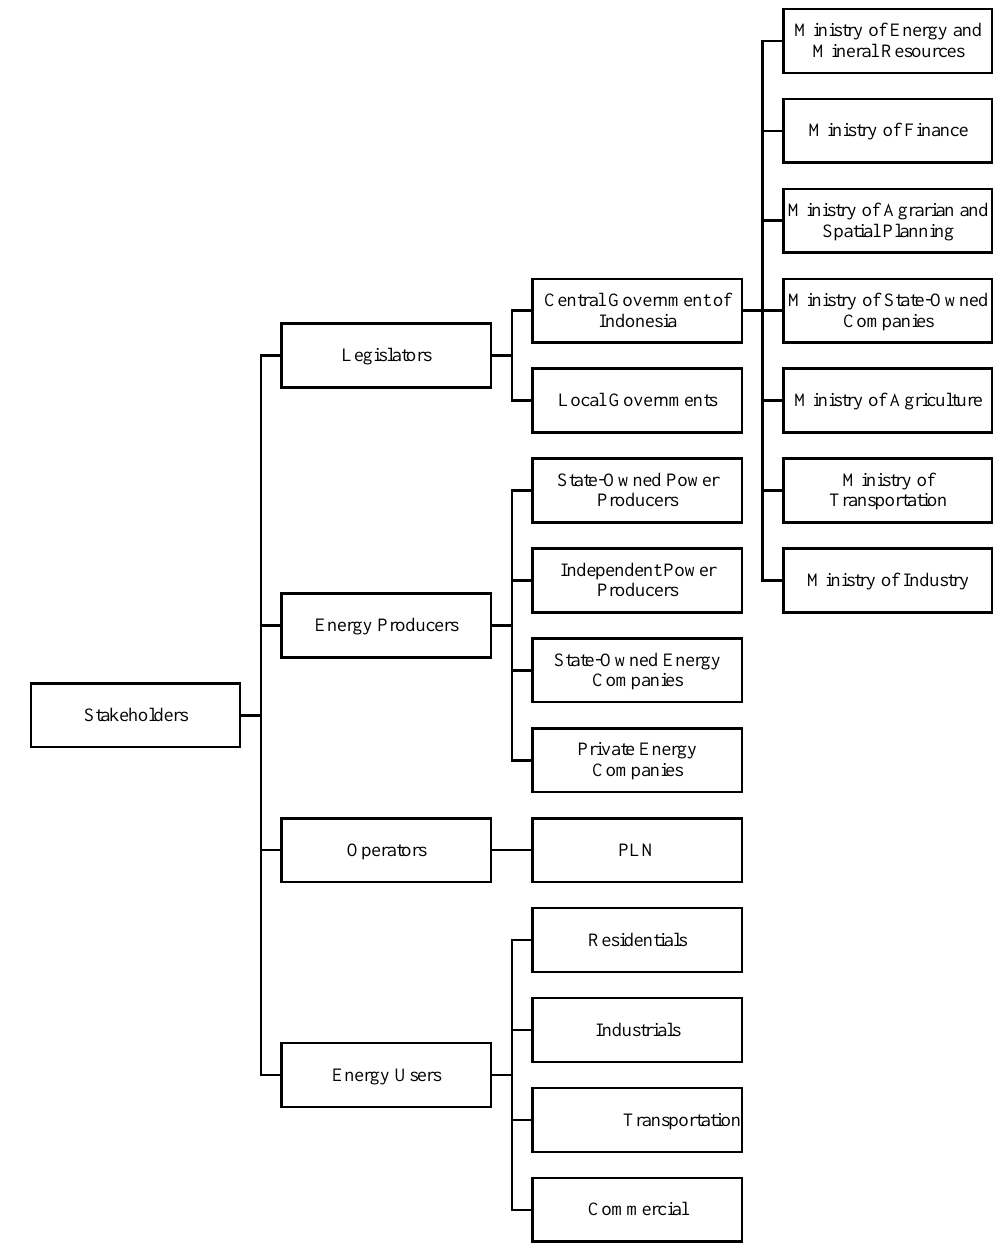
Figure 5. Stakeholders in the renewable energy adoption for electricity generation in Indonesia.